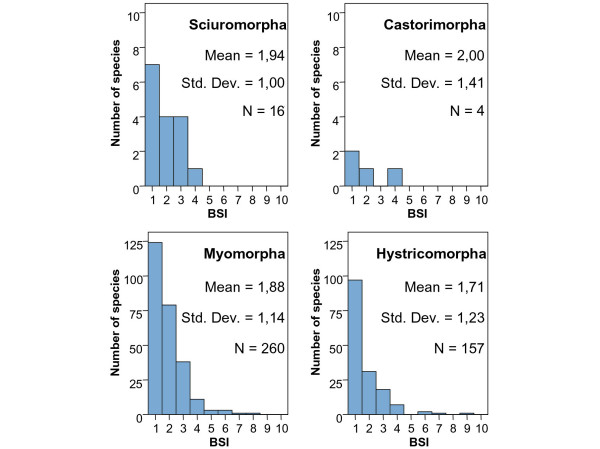
BSI histograms of Rodentia suborders [74].